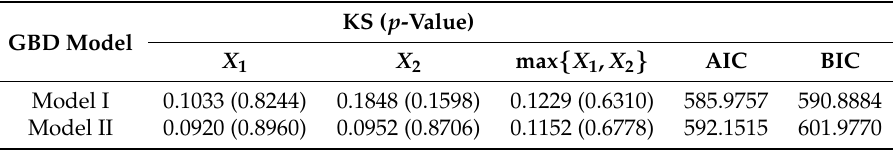
Table 3. Goodness-of-fit results for diabetic retinopathy